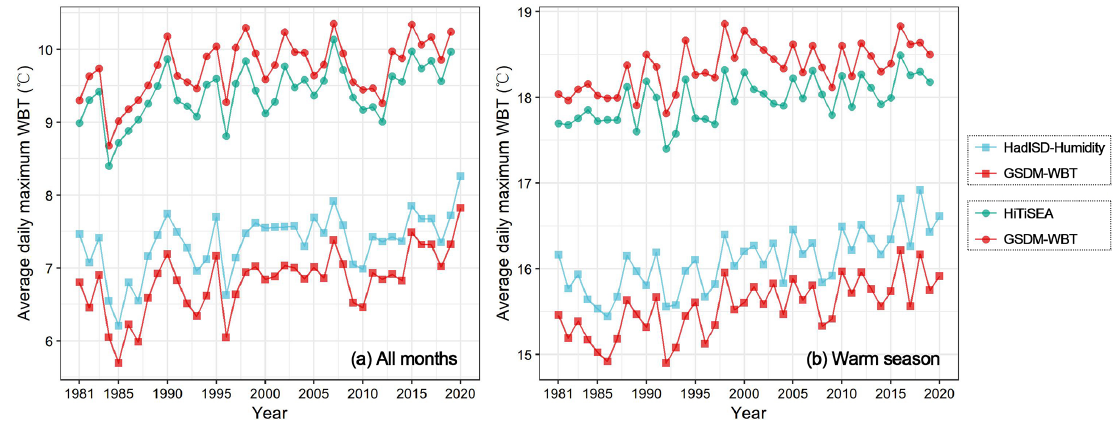
Figure 8. Annual average daily maximum T W between HadISD-Humidity, HiTiSEA, and GSDM-WBT in all months and warm season (May, June, July, August, and September in the Northern